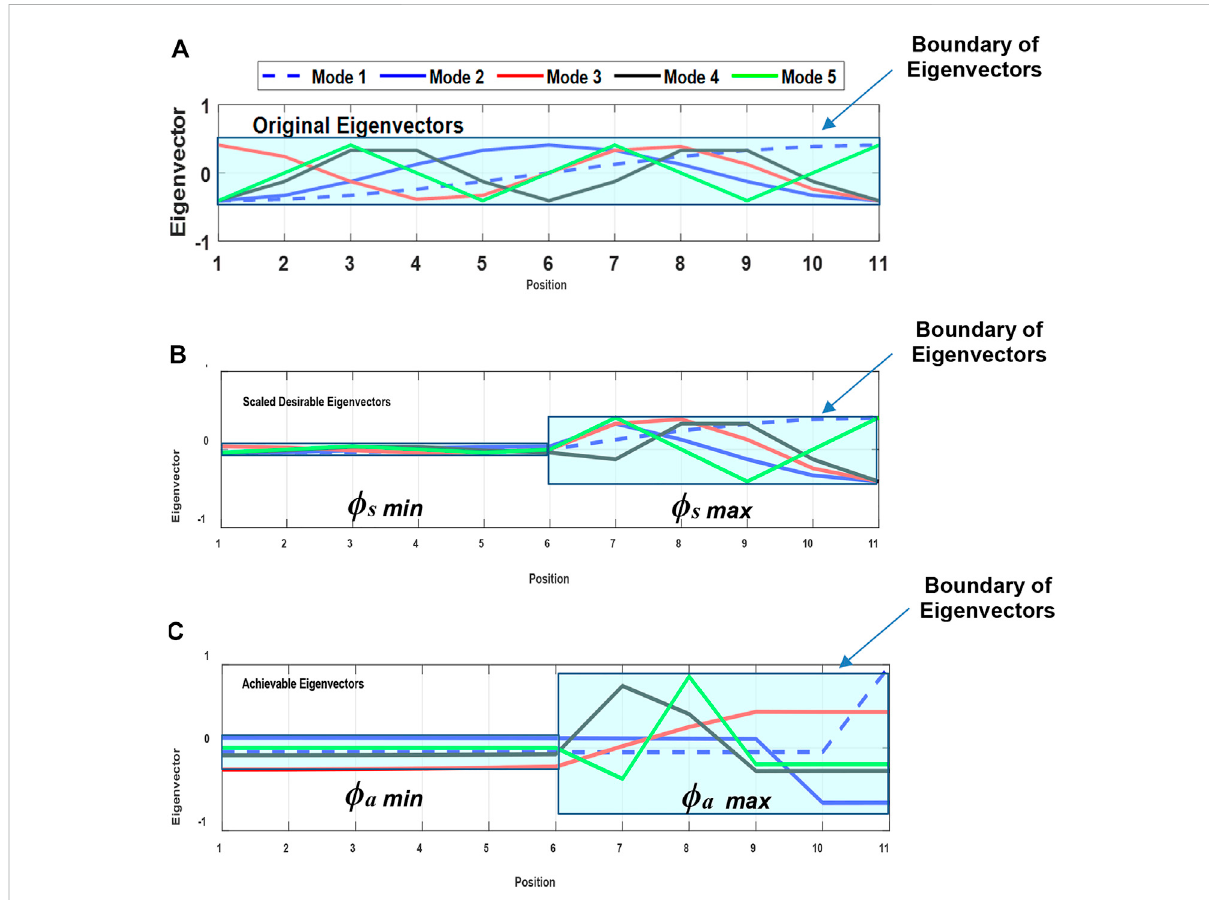
FIGURE 5 Comparison between the original, desirable, and achievable mode shapes (i.e.,